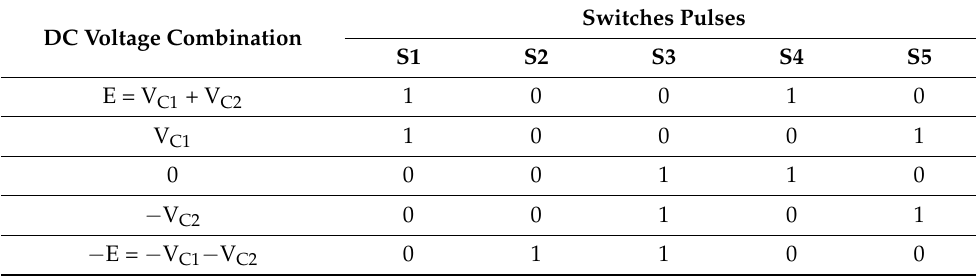
Figure 1. The proposed SPUC5 inverter. Table 1. The switching states of the SPUC5 inverter.